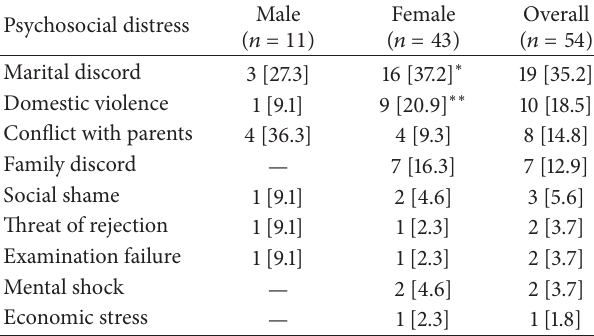
Table 5: Psychosocial causes of DSH among non-psychiatric